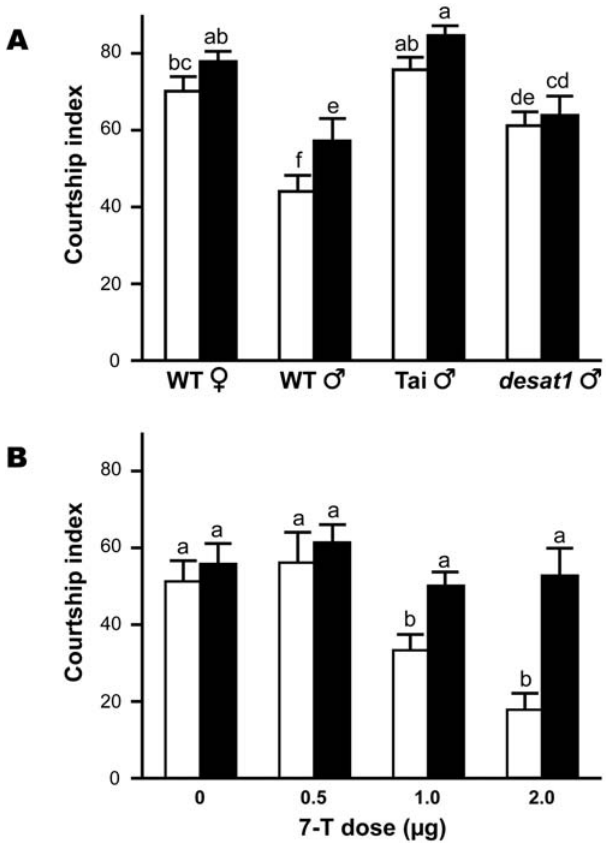
Figure 2. Z-7-tricosene (7-T) inhibits male courtship behavior. Histograms represent the mean courtship index (CI 6 sem) in tester males from the wild-type Canton-S strain (WT; empty bars) and the Gr66a-Gal4/ WT genotype (filled bars) during 10 min under red light. Tests always involved a pair of 5-day-old flies: an intact tester male and a decapitated target fly. ( A ) CIs toward decapitated target flies of four genotypes: WT females and males, Tai and desat1 males. The relatively high homosexual CI shown by WT males toward sibling males can be imputed to the elimination of inhibitory visual and acoustic signals that are emitted by intact males under white light [16,17]. The principal cuticular hydrocarbons of these flies are shown on Fig. 1. ( B ) All tester males courted target desat1 mutant males covered with different doses of synthetic 7-T. The doses shown—0.5 m g, 1.5 m g and 2 m g— respectively correspond to 4, 12 and 16 mM 7-T. ‘‘0’’ corresponds to the solvent (pentane) used to dissolve 7-T. A similar amount of solvent was used for all tests (0.8 m l). All data were Arcsin transformed and tested using two-factors ANOVA and PLSD Fisher test. For each data set, differences were tested between subjects, between objects and for the interaction between factors: for A, p =0.004; 0.001; 0.863, respectively; for B, p =0.002; 0.001; 0.098, respectively. Significant difference ( p , 0.05) for each set of data are indicated by letters above each bar (same letters=no difference);